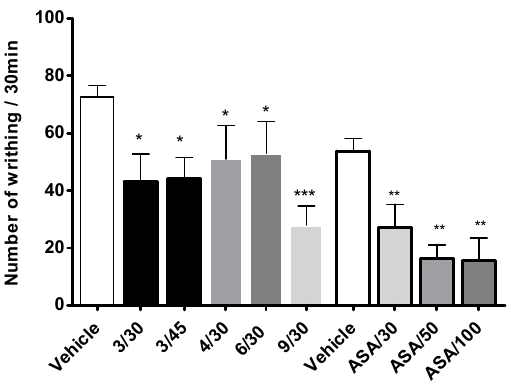
Figure 3. Antinociceptive activity of compounds 3 , 4 , 6 , 9 and acetylsalicylic acid (30, 50, and 100 mg /